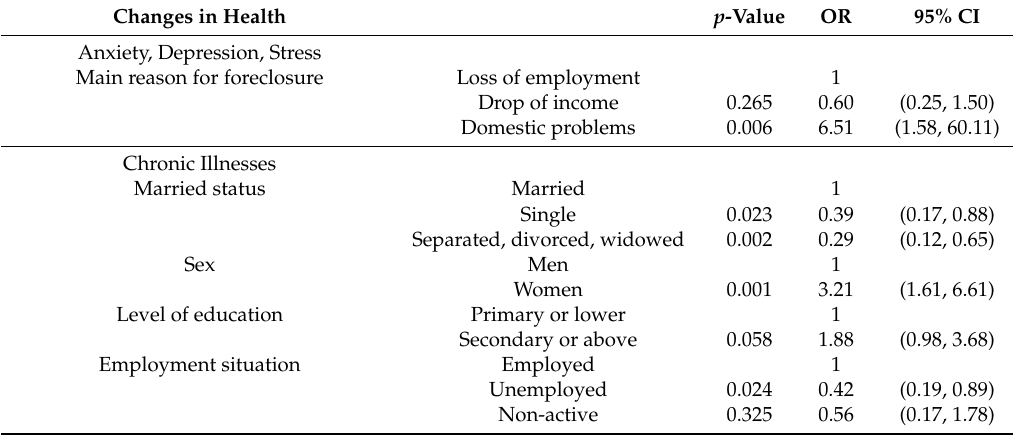
Table 4. Multivariate penalized logistic regression models for changes in health, use of health services, consumption of medication, and health related